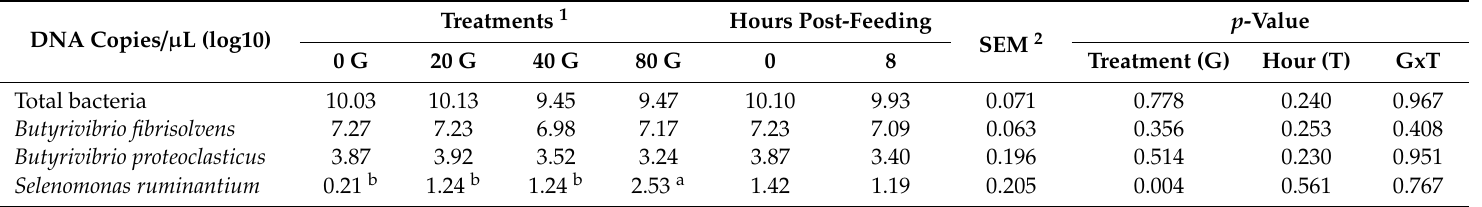
Table 4. The e ff ect of feeding glycerin on the total bacteria, Butyrivibrio fibrisolvens , Butyrivibrio proteoclasticus (previously called Clostridium proteoclasticum ), and Selenomonas ruminantium in the DNA extract of rumen fluid from young bulls that were fed a high level of